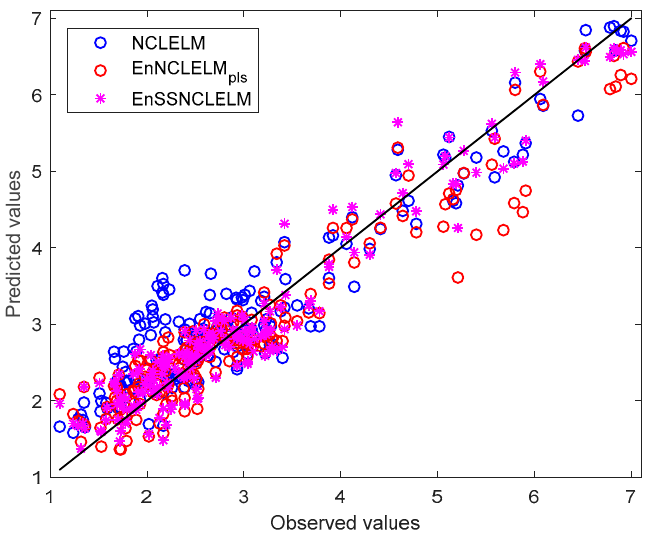
Figure 10. Scatter plots of the observed and predicted substrate concentration using the NCLELM, EnNCLELM pls , and EnSSNCLELM methods.